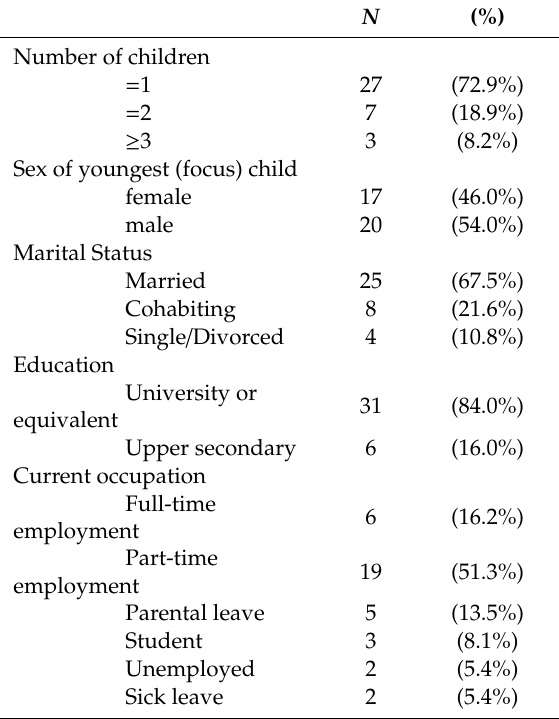
Table 2. Description of Study Participants ( N =